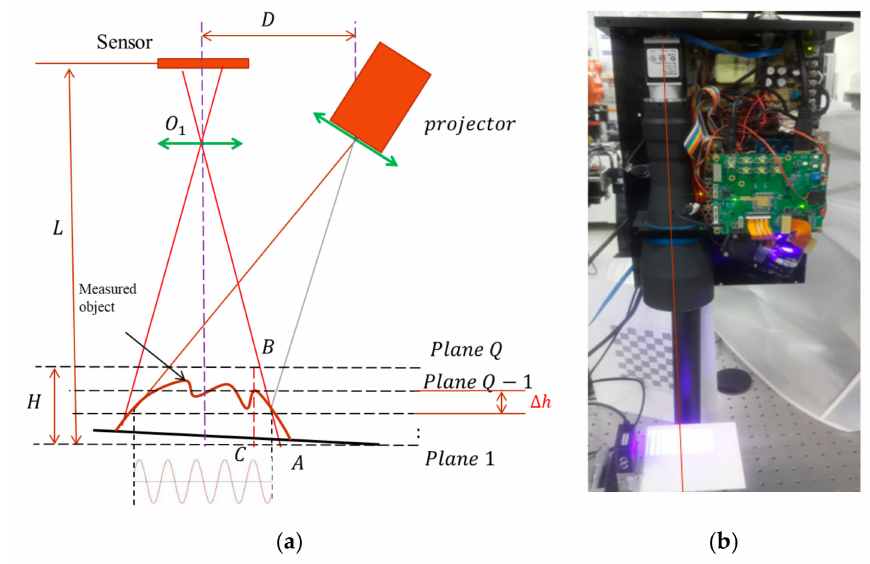
Figure 9. ( a ) Schematic diagram of a multifrequency phase-shifting (MFPS) system setup and ( b ) a real measurement